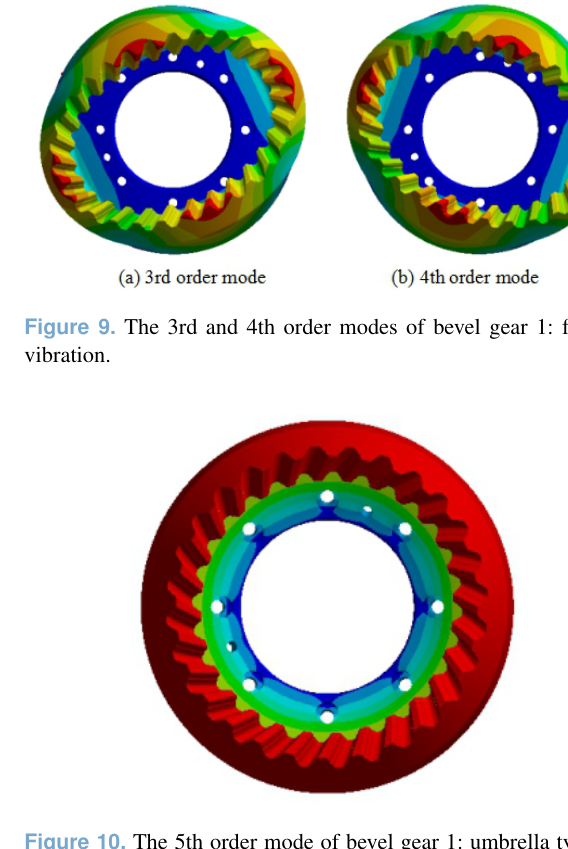
Figure 10. The 5th order mode of bevel gear 1: umbrella type vi- bration.